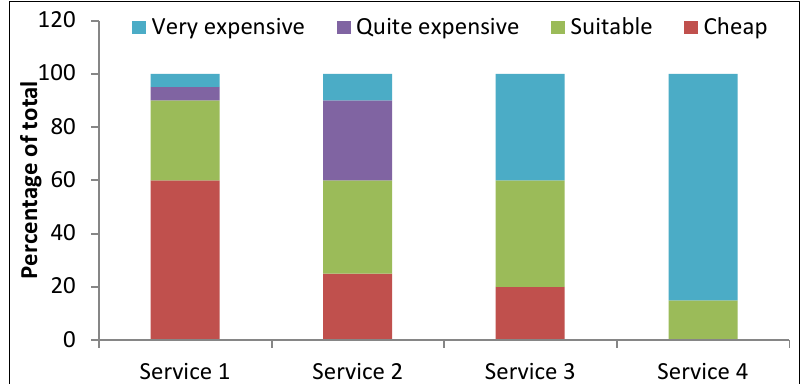
Figure 4. Perception of the prices of the services.